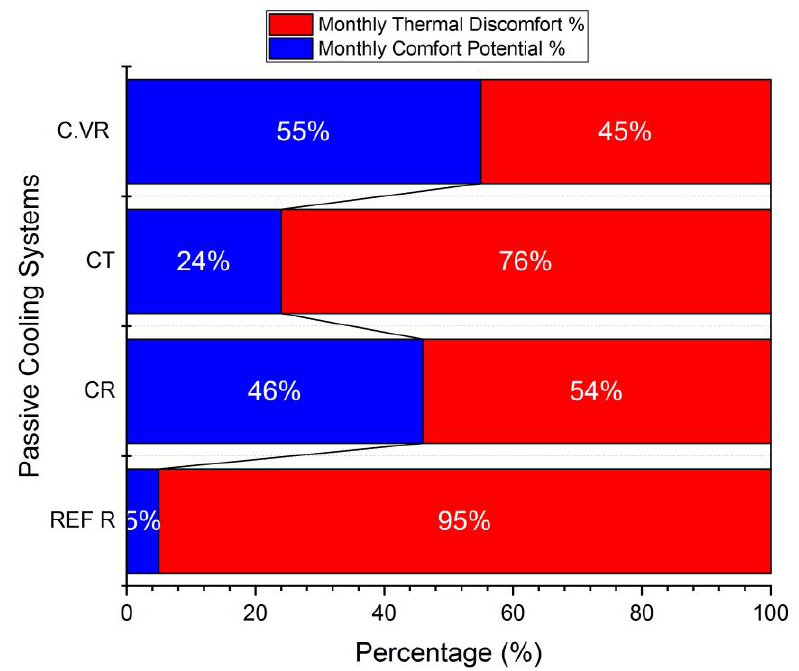
Figure 12. Percentage of potential comfort ensured during the hottest month and percentage of discomfort hours for the three roofing alternatives.